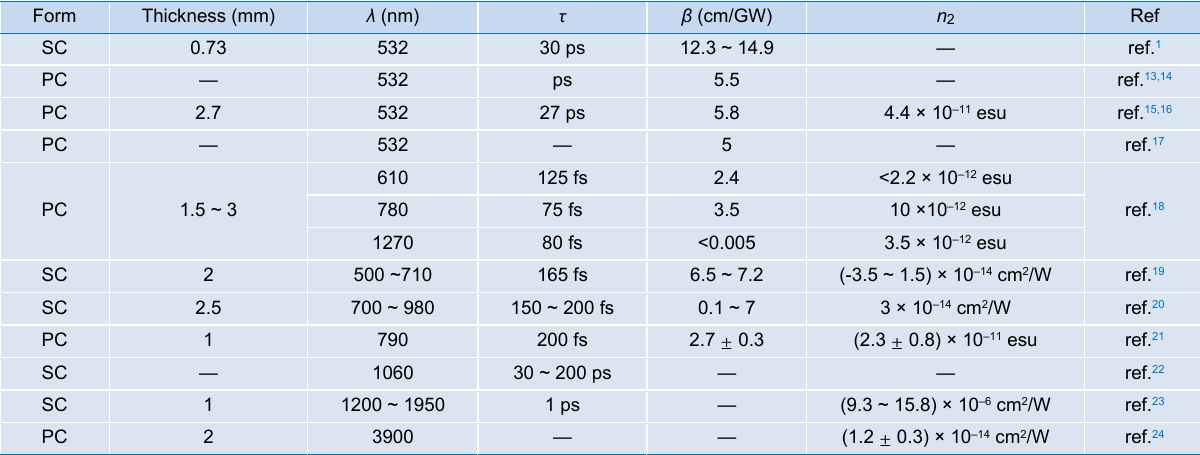
Table 1 | Selection of literature to date on optical properties of ZnSe with laser excitation from fs to ps temporal pulse lengths.